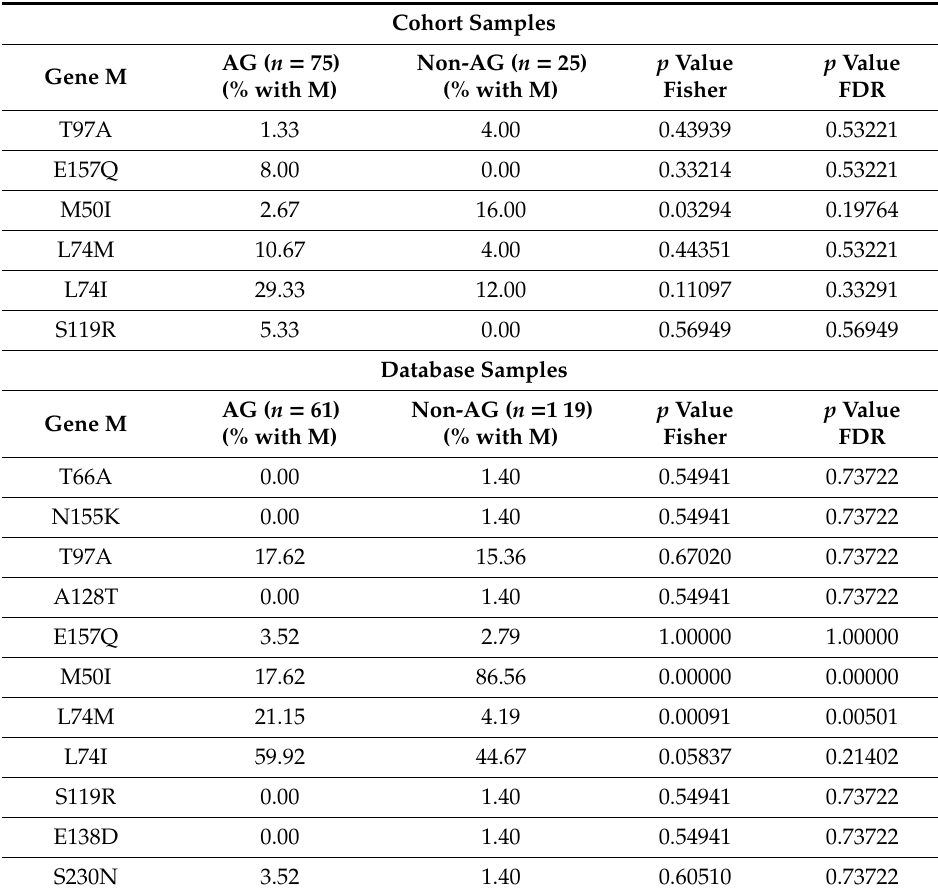
Table 4. Integrase gene mutations in cohort and database AG and non-AG